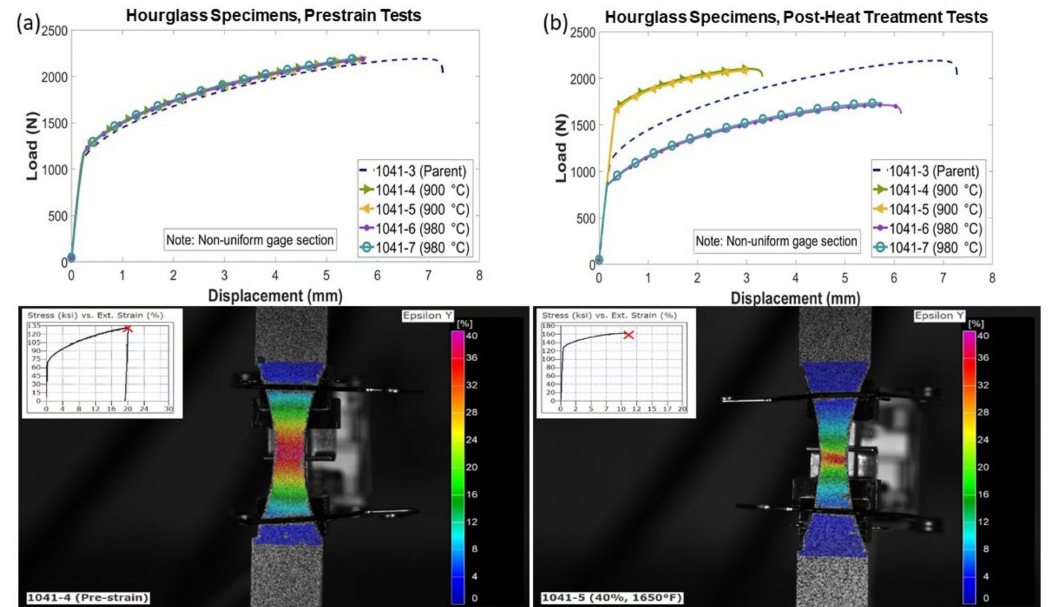
Figure 10. Tensile response for hourglass specimens prestrained to 40% maximum local strain with varying degrees of heat treatment with the DIC images underneath each graph. ( a ) shows the prestraining of the samples to 40% and ( b ) shows the final mechanical response post-heat treatment.